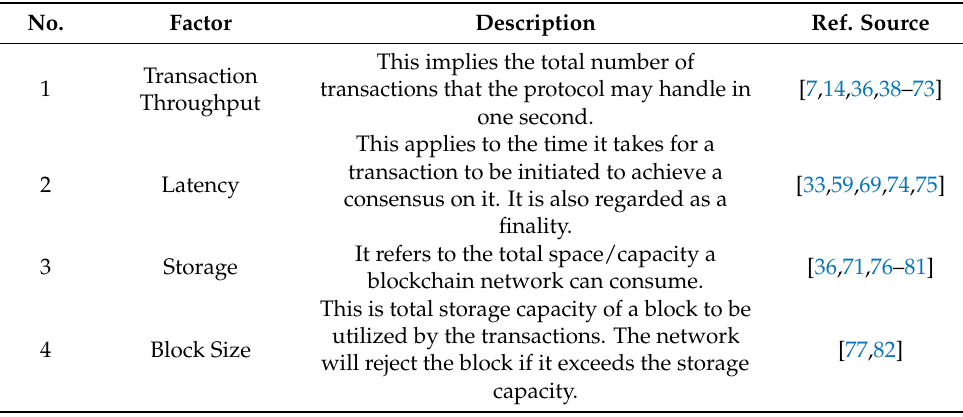
Figure 8. Identified factors causing scalability issue in public blockchains. Table 4. Factors related to blockchain scalability.